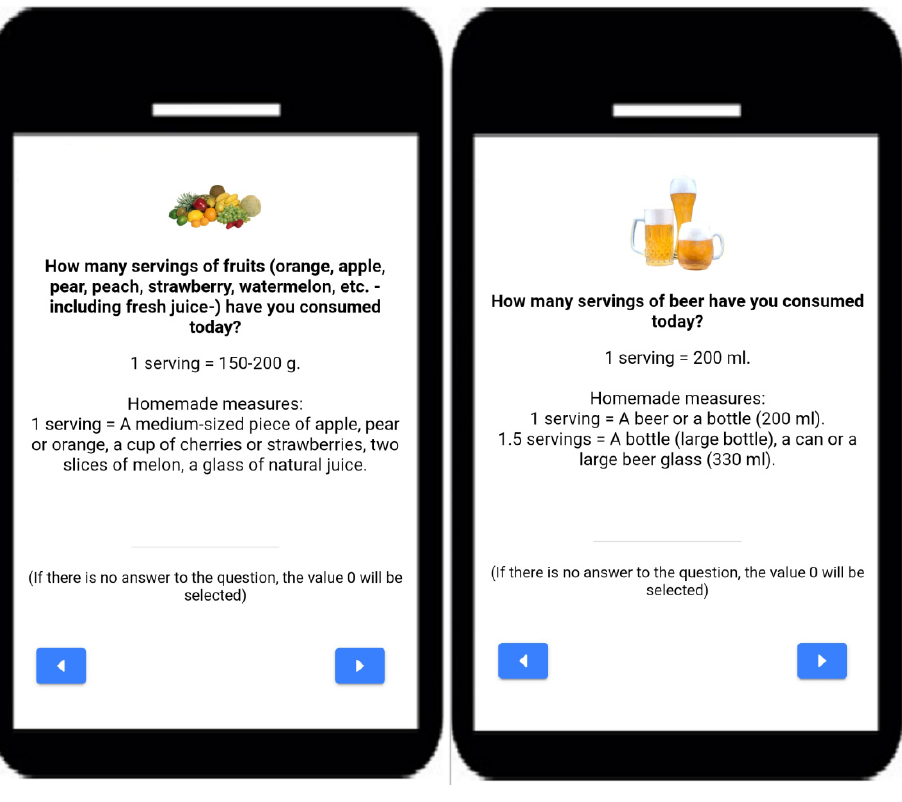
Figure 1. Screenshots from the e-12HR app.